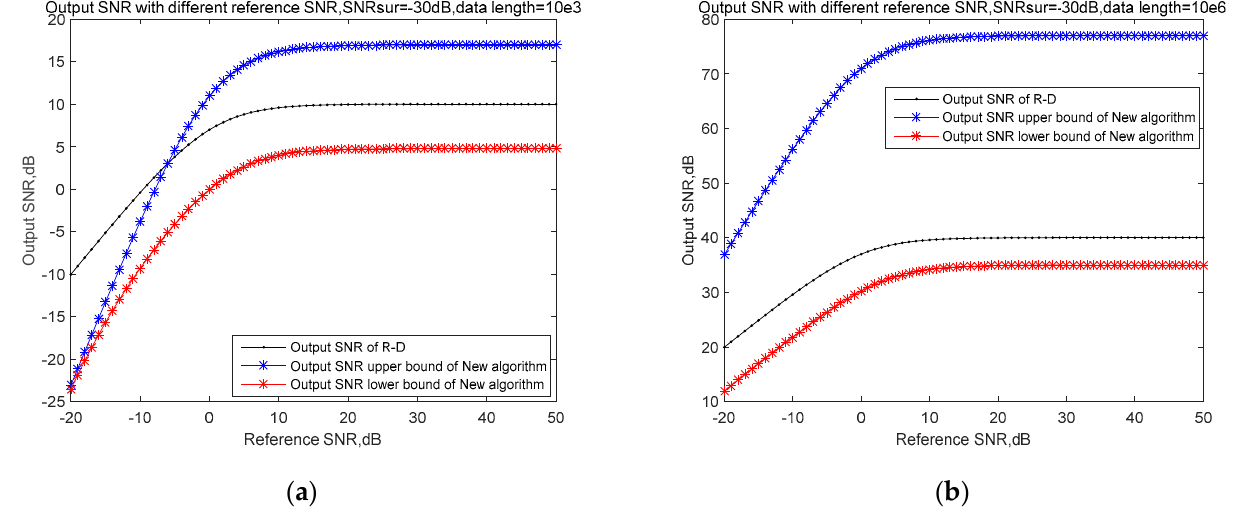
4 , ( b ) N = 10 6 sur = − 30 dB: ( a ) N = 10